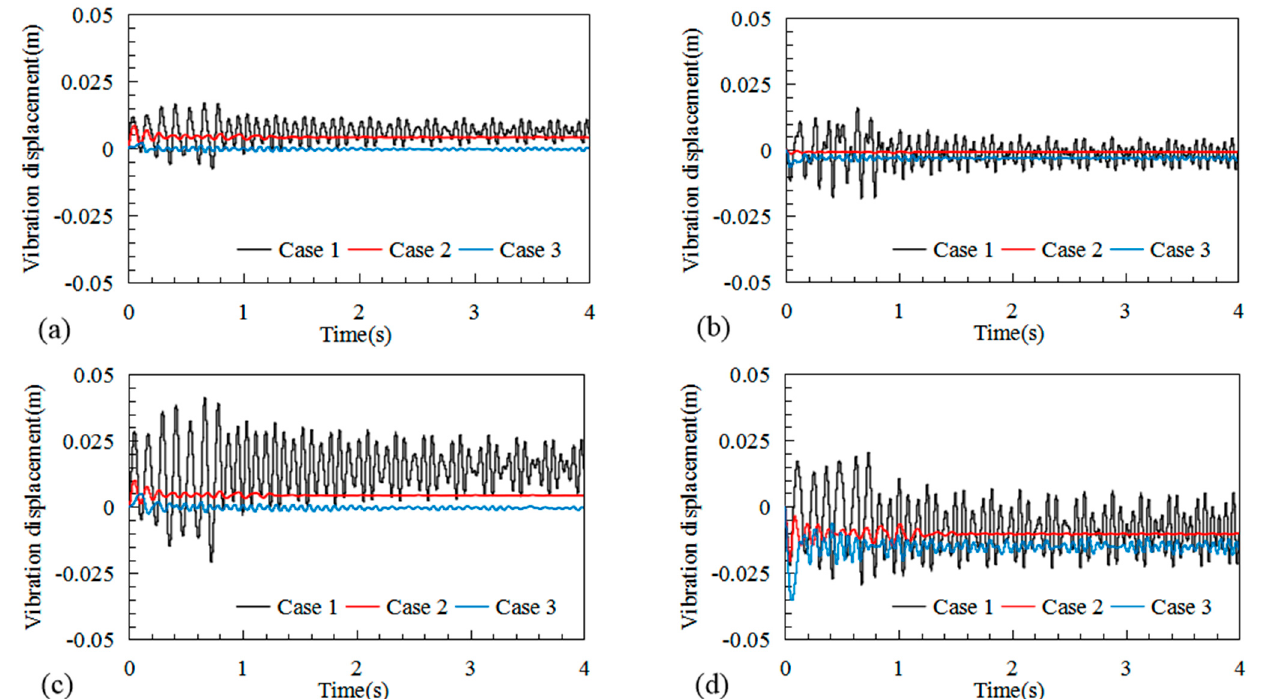
Figure 12. Displacement time-history curve: ( a ) d1, ( b ) d2, ( c ) d3, ( d ) d4.